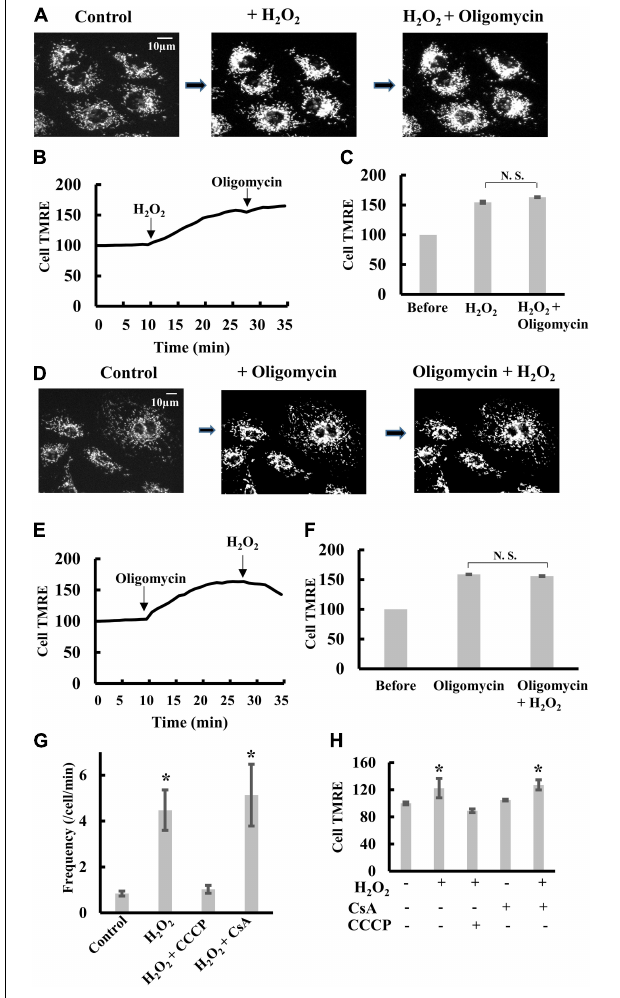
FIGURE 6 | Effects of H 2 O 2 on transient depolarization of mitochondria in H9c2 cells. (A–C) TMRE fluorescence in H9c2 cells upon sequential addition of H 2 O 2 and oligomycin. H 2 O 2 (1 mM) and oligomycin (5 µ M) were added in order. (A) Fluorescence images of TMRE in H9c2 cells. (B) The time course of changes in Cell TMRE averaged over 10 H9c2 cells. Arrows indicate the addition of H 2 O 2 or oligomycin. The fluorescence at t = 0 was normalized to 100%. (C) Cell TMRE before the addition of H 2 O 2 and oligomycin was normalized to 100%. When H 2 O 2 or oligomycin was present, cells were incubated with H 2 O 2 or oligomycin for 20 min before measurements. (D–F) TMRE fluorescence in H9c2 cells upon sequential addition of oligomycin and H 2 O 2 . Oligomycin (5 µ M) and H 2 O 2 (1 mM) were added in order. (D) Fluorescence images of TMRE in H9c2 cells. (E) The time course of changes in Cell TMRE averaged over 10 H9c2 cells. Arrows indicate the addition of H 2 O 2 or oligomycin. The fluorescence at t = 0 was normalized to 100%. (F) Cell TMRE before addition of H 2 O 2 and oligomycin was normalized to 100%. When H 2 O 2 or oligomycin was present, cells were incubated with H 2 O 2 or oligomycin for 20 min before measurements. (G) Frequency of transient depolarization of mitochondria in H9c2 cells. The frequency is shown as the number of depolarizations/min/cells. CCCP and CsA were added as described in figure legends for Figure 3 . When H 2 O 2 was present, cells were incubated with H 2 O 2 for 20 min before measurements. (H) Statistical analysis of Cell TMRE in H9c2 cells. H 2 O 2 , CCCP and CsA were added as described for (G) . Values represent the mean ± SEM ( n > 10). * p < 0.05 vs. control for (G) ; without CCCP, H 2 O 2 and CsA for (H)